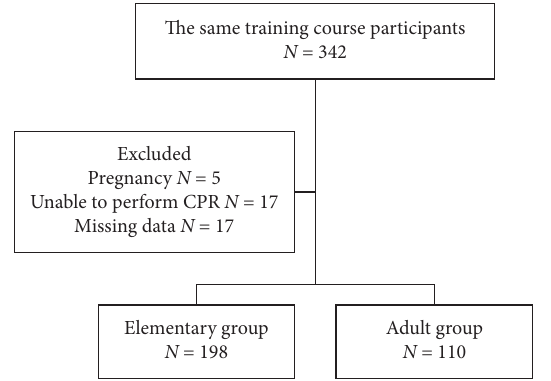
Figure 1: Flowchart. N : number; CPR: cardiopulmonary resuscitation.